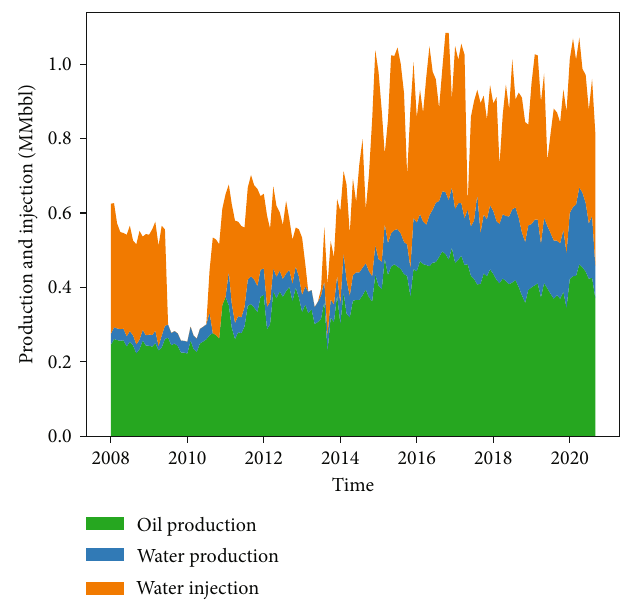
Figure 9: Reservoir development performance after water fl ooding